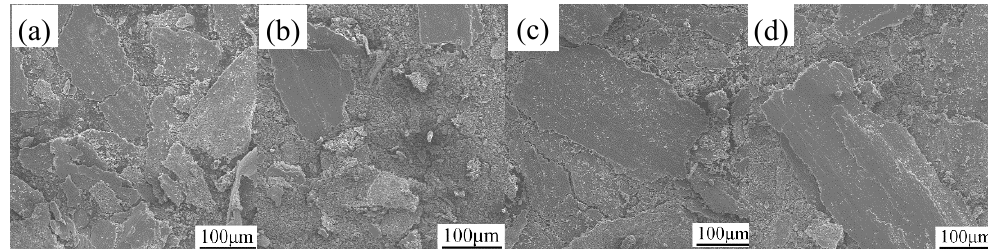
Figure 11. SEM images of the wear debris on rheocast 7075 specimens formed under different friction loads: ( a ) 30 N, ( b ) 60 N, ( c ) 90 N, and ( d ) 120 N.